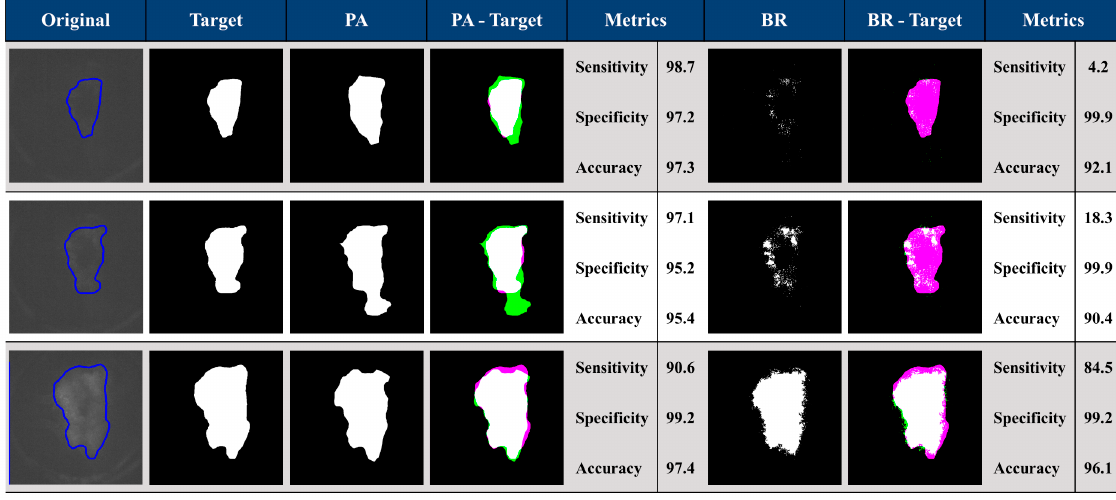
Figure 16. Evaluation of the metric at λ = 1.6 CSI.